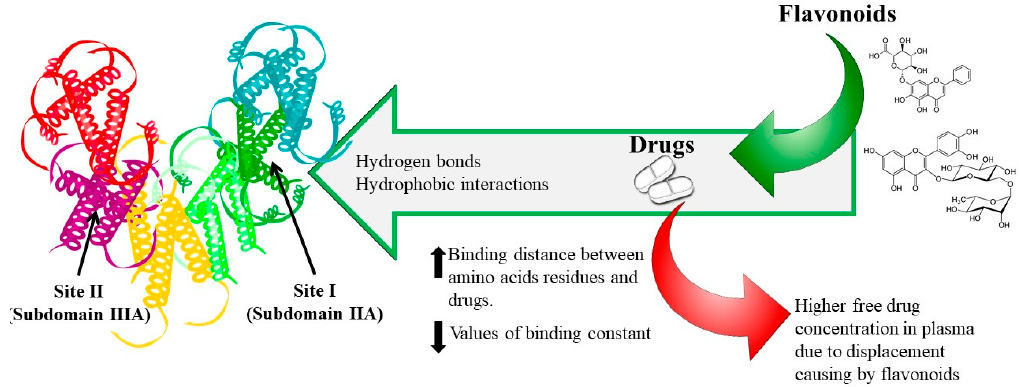
Figure 3. Dietary flavonoid–drug interaction mechanism.